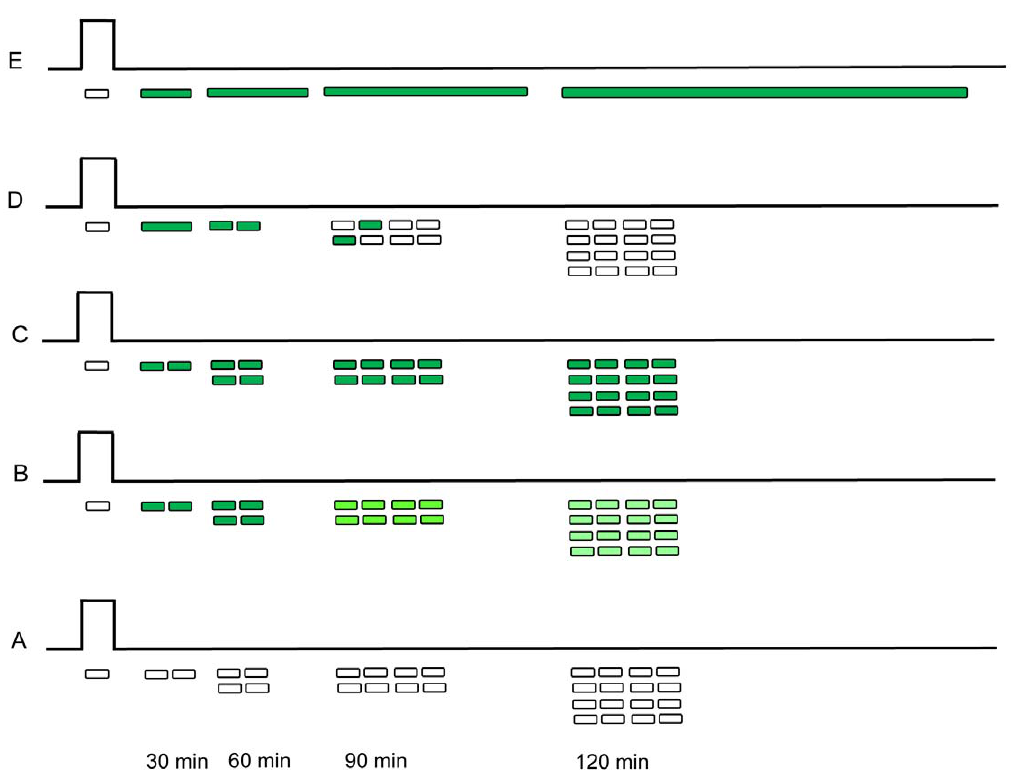
Figure 3. Schematic illustration of the proposed bacterial time-stamp devices. Panel B outlines the expected behavior of cells wherein transient exposure to a signal molecule rapidly induces expression of a fluorescent reporter protein followed by periodic reduction in fluorescent intensity upon removal of the signal molecule. Brief signal exposure of bacteria containing only the toggle switch driving expression of a fluorescent reporter protein (C) would result in fluorescence in the dividing progeny, while identical signal exposure in bacteria containing a plasmid capable of constitutive expression of a cell-division inhibitor and a fluorescent reporter protein (D) would eventually result in non-elongating and non- fluorescent progeny. Only bacteria containing a toggle switch driving expression of a fluorescent reporter protein and a cell-division inhibitor protein (E) are expected to display fluorescence and sustained cellular elongation in progenitor cells, the length of which could be used to calculate time elapsed following signal exposure. Control bacteria devoid of toggle switch are represented as